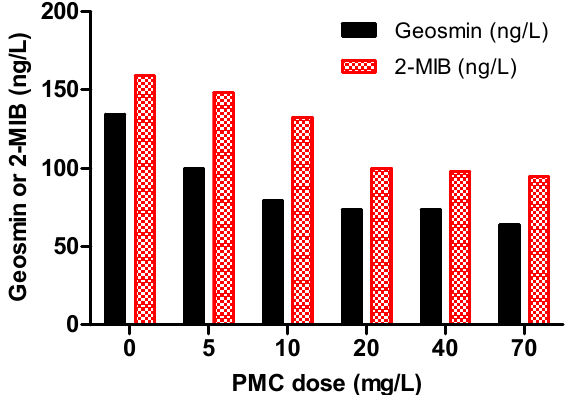
Figure 6. Trends in geosmin and 2-methylisoborneol (2-MIB) removal by PMC processes at the lab-scale (initial geosmin concentration = 134.58 ng/L; initial 2-MIB concentration = 159.02 ng/L; PMC dose: 0, 5, 10, 20, 40 and 70 mg/L).